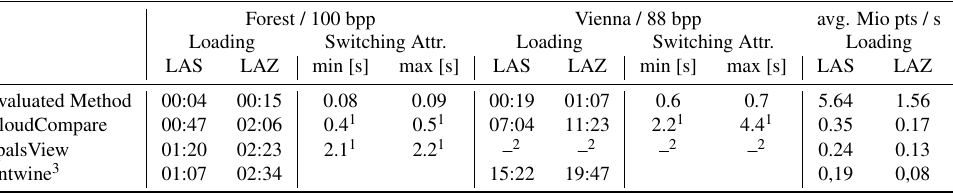
Table 3. Import/Loading duration [mm:ss] for LAS/LAZ files with standard attributes. 1 Crash while loading. 2 Loading aborted without message. 3 Loading without indexing/No LAZ support. 4 Hierarchical Structure Generator only.